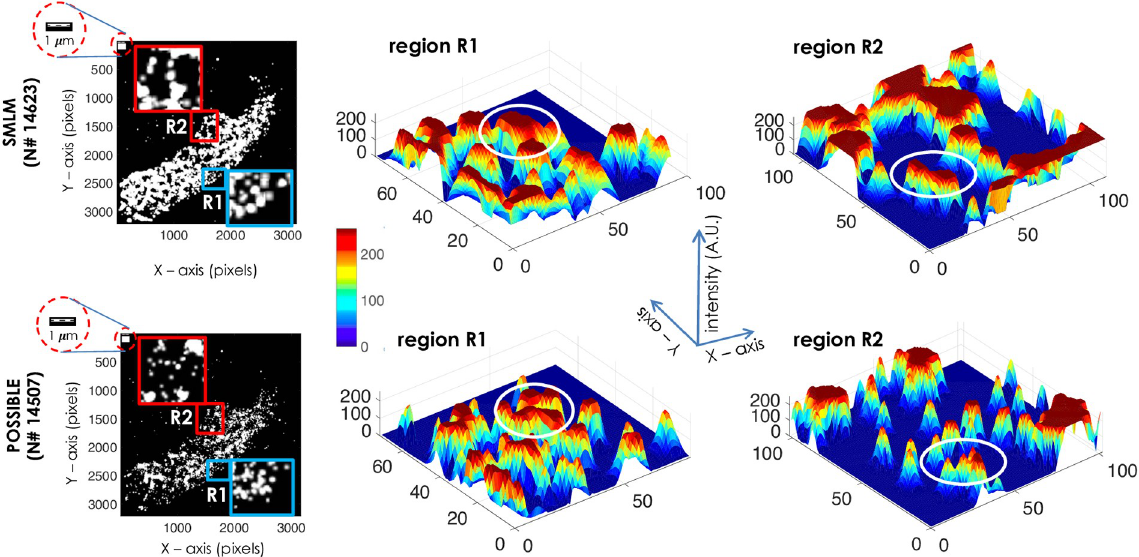
Fig 4. Cluster visualization. SMLM and POSSIBLE reconstructed images along with the zoomed version of two different clusters (marked by blue and red rectangles). 3D surface plot of two chosen clusters (marked by R1 and R2) are shown where the marked black ellipses indicate sub- clusters within large clusters. Visually, the resolving ability of POSSIBLE microscopy is quite apparent. Scale bar is 1 μm .